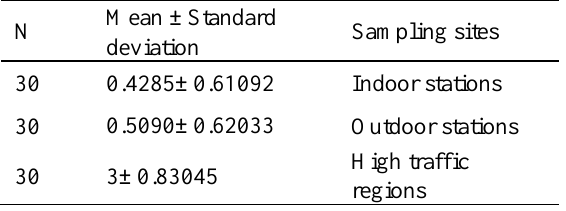
Table 3. Mean heavy metal concentrations in indoor and